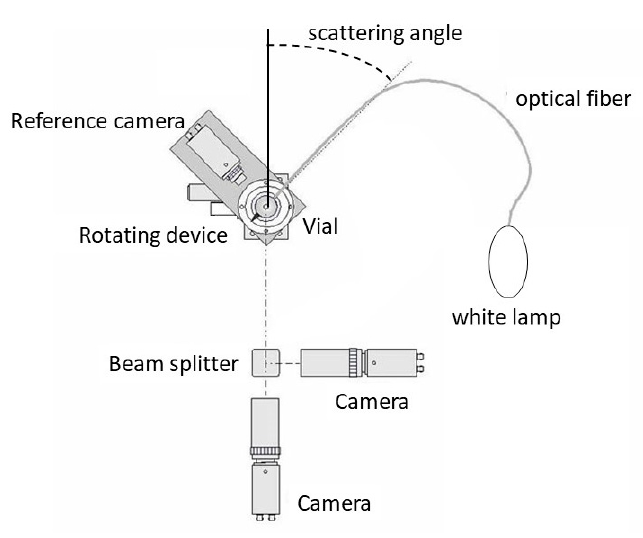
Figure 3. Concept of measurement with the PROGRA2 instrument.